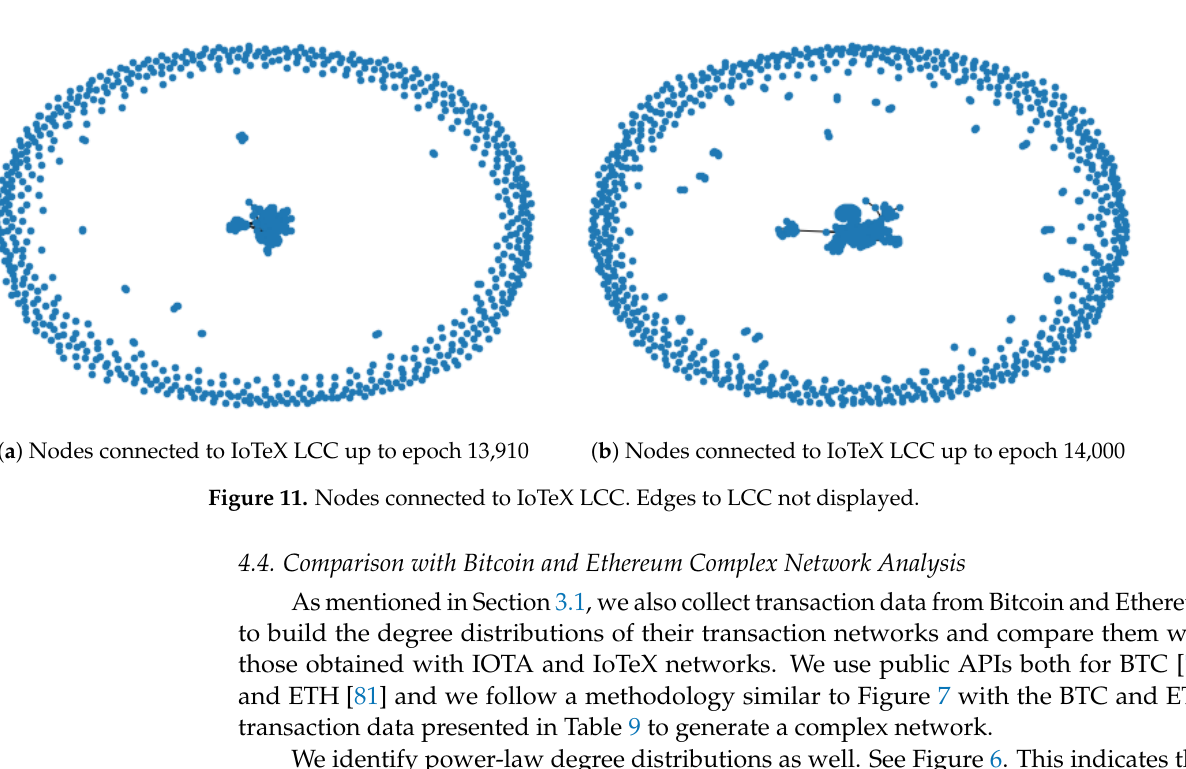
Figure 10. Nodes connected to IOTA LCC. Edges to LCC not displayed.